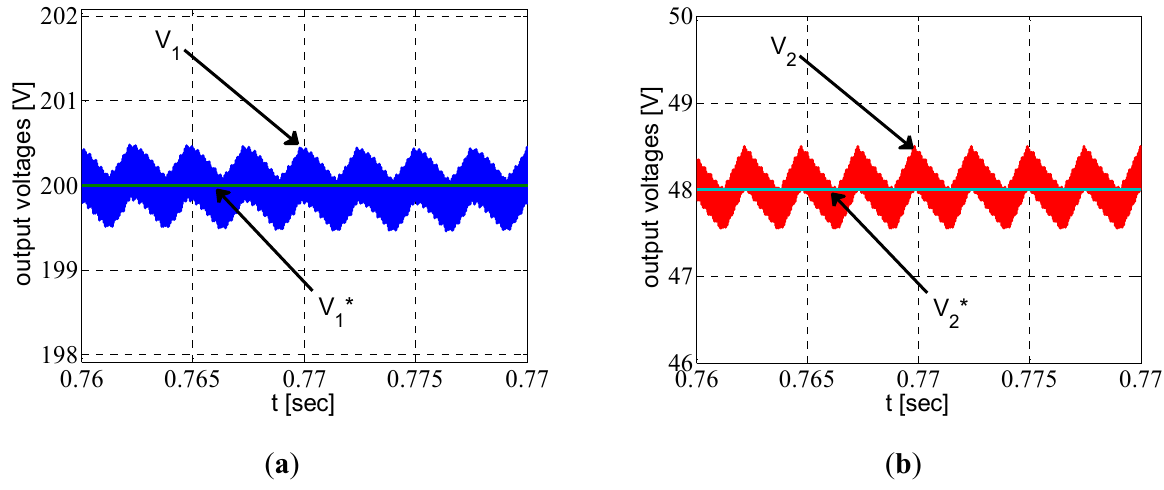
Figure 10. Fixed voltage and load results: ( a ) higher output voltage; ( b ) lower output voltage.